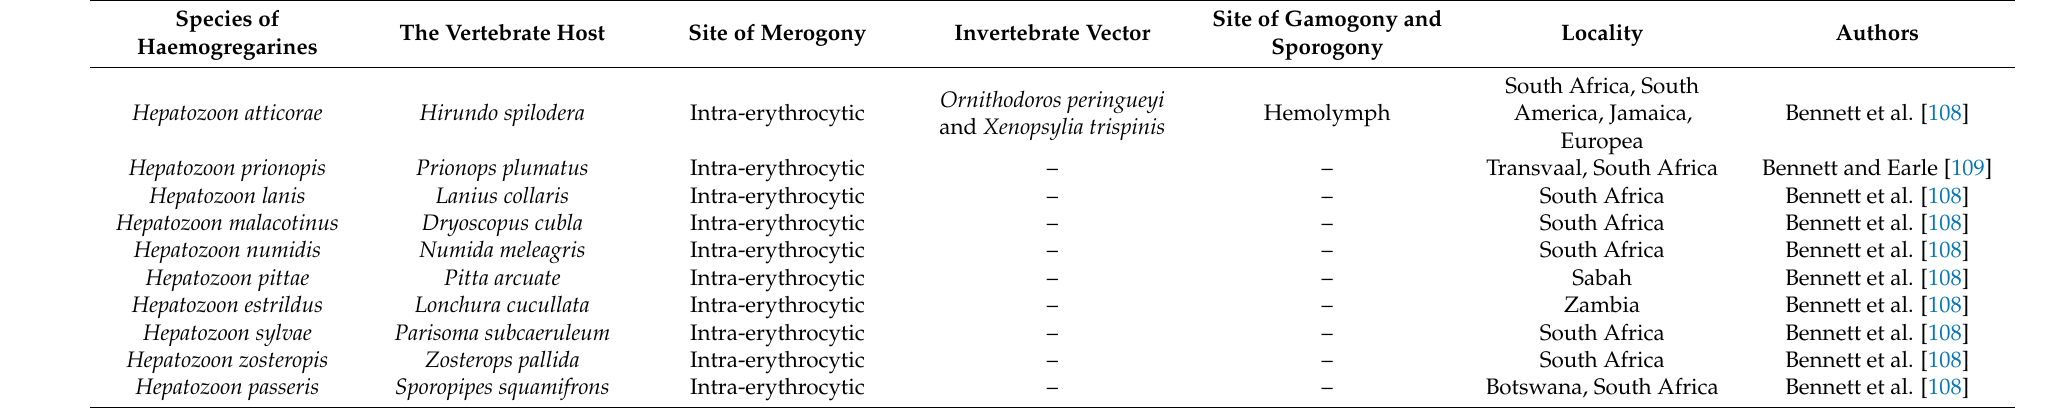
Table 8. Haemogregarines of